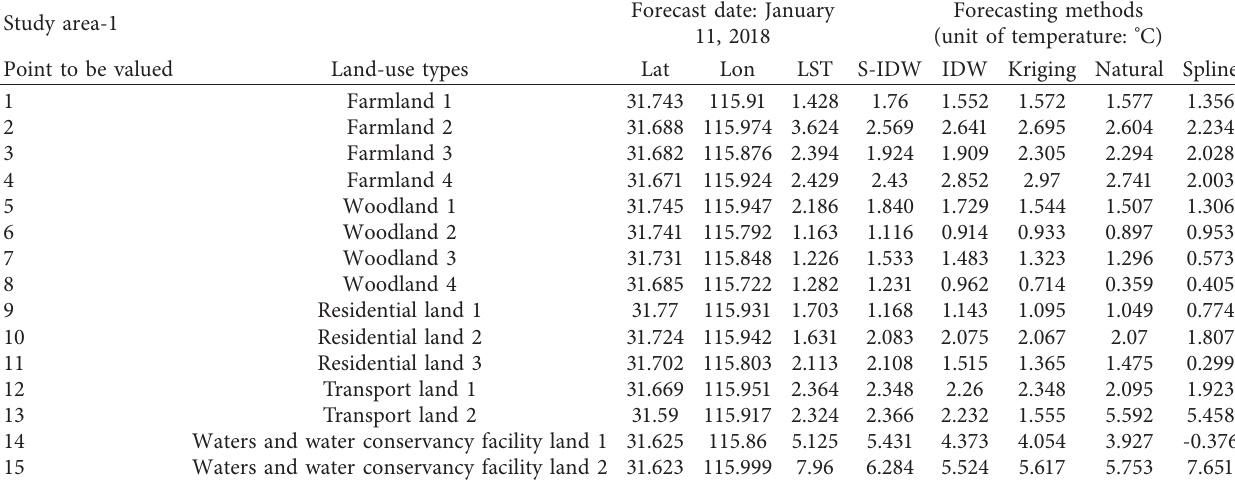
Table 3: Comparison of interpolation results of 5 kinds of interpolation methods on Jan. 11, 2018. Study